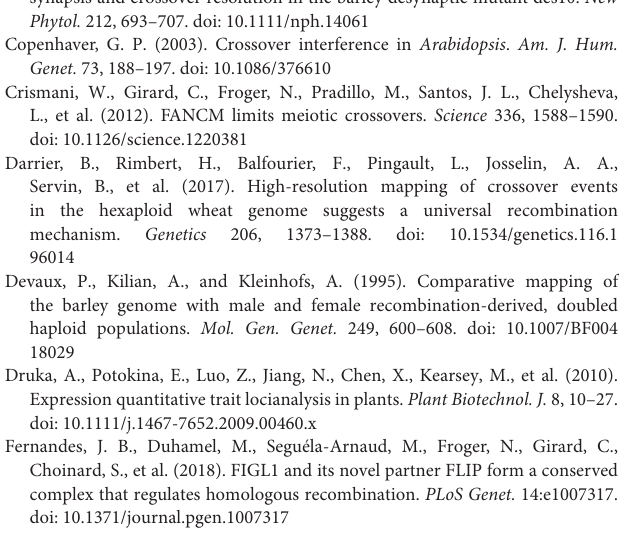
Supplementary Figure 1 | Suppressor screening population development and process summary. Supplementary Figure 2 | (A) Outline of the development of F 3 populations to be genotyped. (B) Selection of the genotypes across the generations to create F 3 populations. SuppLine2099 was crossed with cv . Barke background to generate heterozygous F 1 s, which were grown to produce F 2 seed. F 2 plants were grown and selected by using Kompetitive allele-specific PCR (KASP) genotyping for targeting the segregating mutations. Only the four homozygous combinations were selected to be grown as F 2 families and produce F 3 seeds. These were later grown and genotyped with the 50K assay to study the effect of the mutation in F 2 recombination. The alleles in the mutated genes are indicated by the square box color, being green for the wild type (WT)-like allele, dark red for the